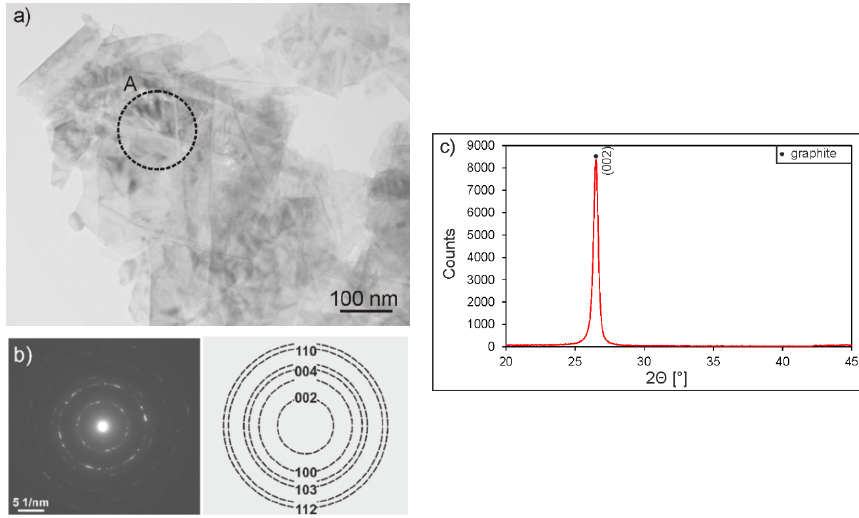
Figure 1. Transmission electron microscopy (TEM) micrograph ( a ) and selected area electron diffraction (SAED) pattern of the area marked as A in Figure 1a with identification ( b ), as well as the X-ray diffraction (XRD) pattern ( c ) of graphite particles consisting of graphene layers stacked together.